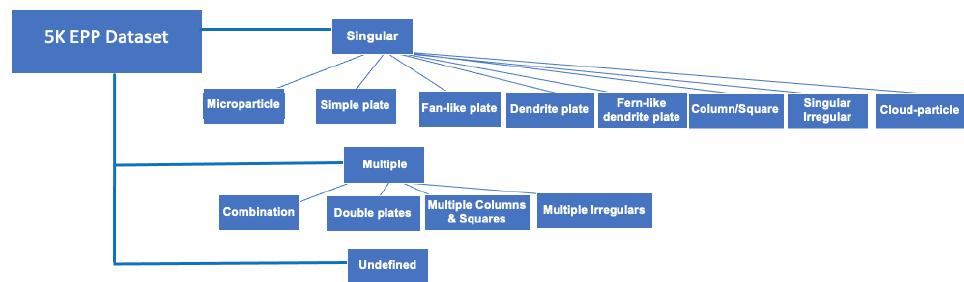
Figure 1. A tree-like diagram to demonstrate the water crystal categories with 5K EPP